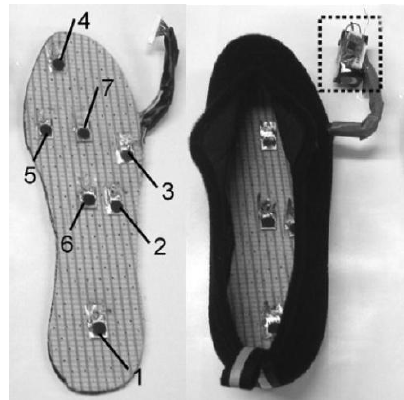
Figure 31. The seven sensors placement and the complete shoe. The box inlet is the power source, wireless transmitter and pressure measurement unit